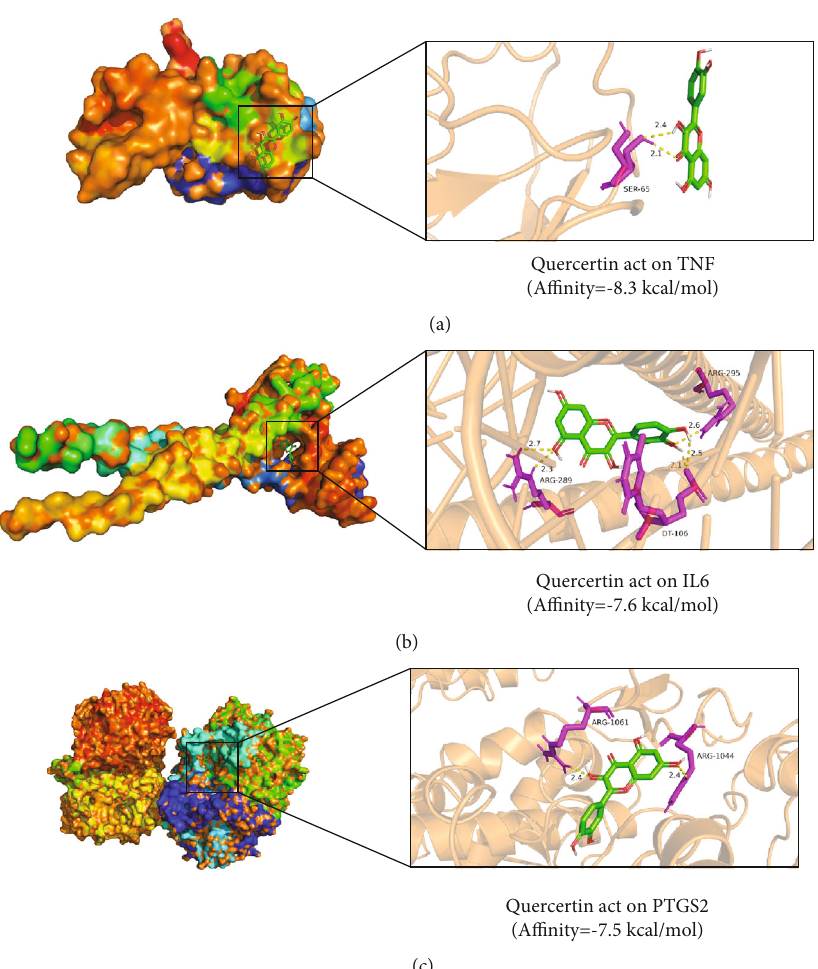
Figure 6: Molecular docking model of the top 3 key target proteins with the highest docking scores docked with quercetin. (a) TNF, (b) IL6, and (c)